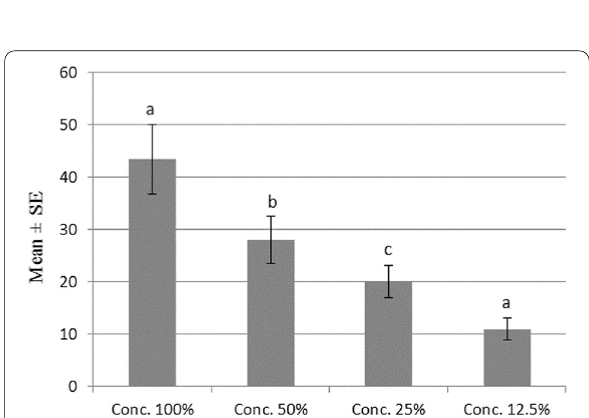
Fig. 4 Mortality of Locusta migratoria migratorioides after treatment with 4 concentrations of cell-free filtrate of Photorhabdus luminescens (EGAP3). Bars (mean SE in the same and between time intervals ± with the same letter(s) are not significantly different ( P < 0.005)